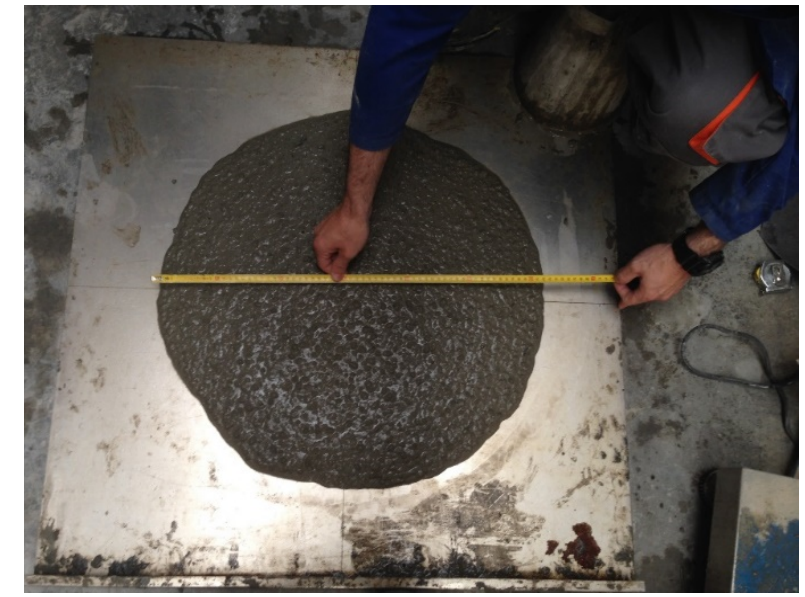
Figure 3. Slump flow test diameter measurement example.